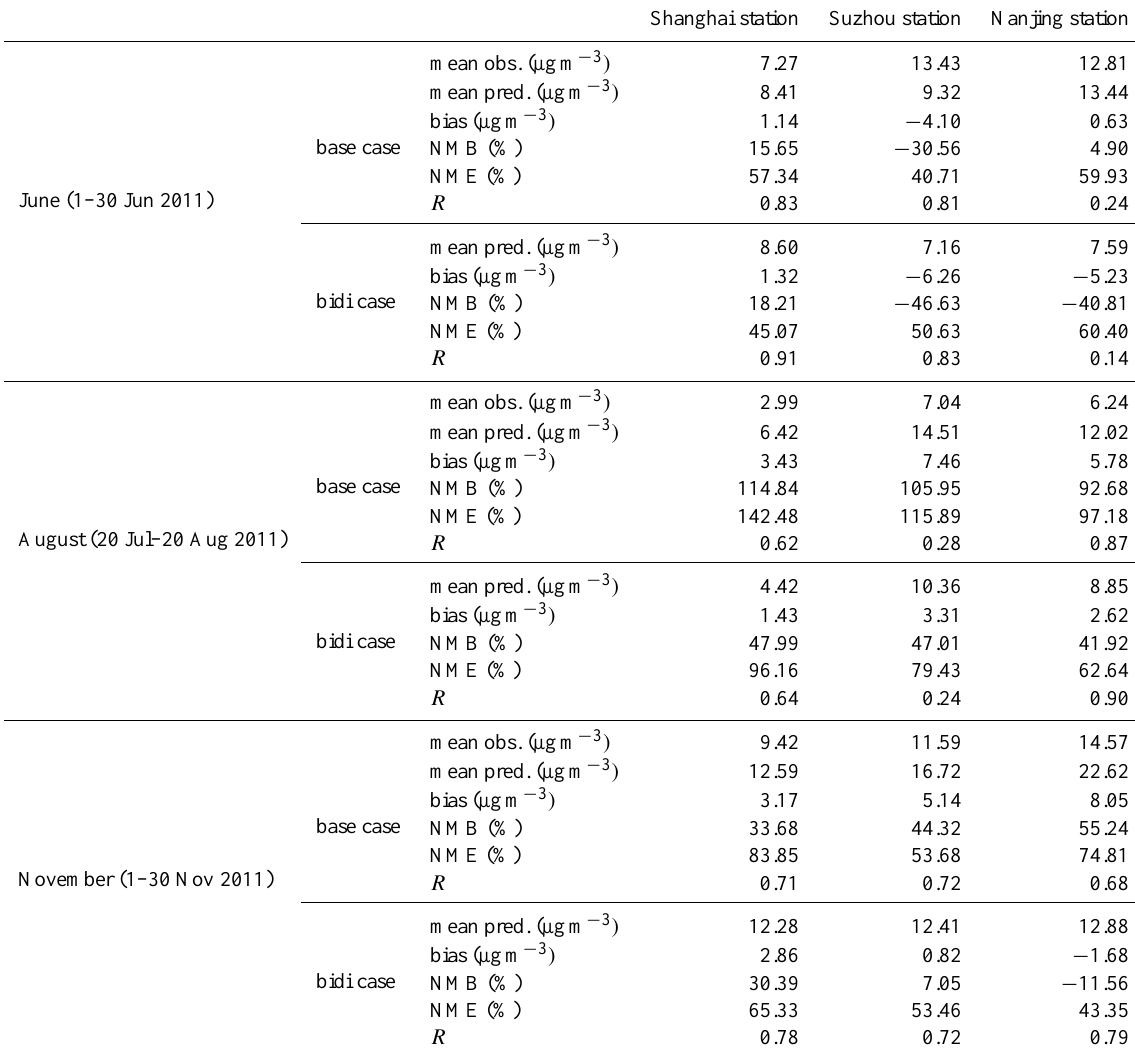
Table 4. The performance statistics of CMAQ-modeled daily NO − at three monitoring